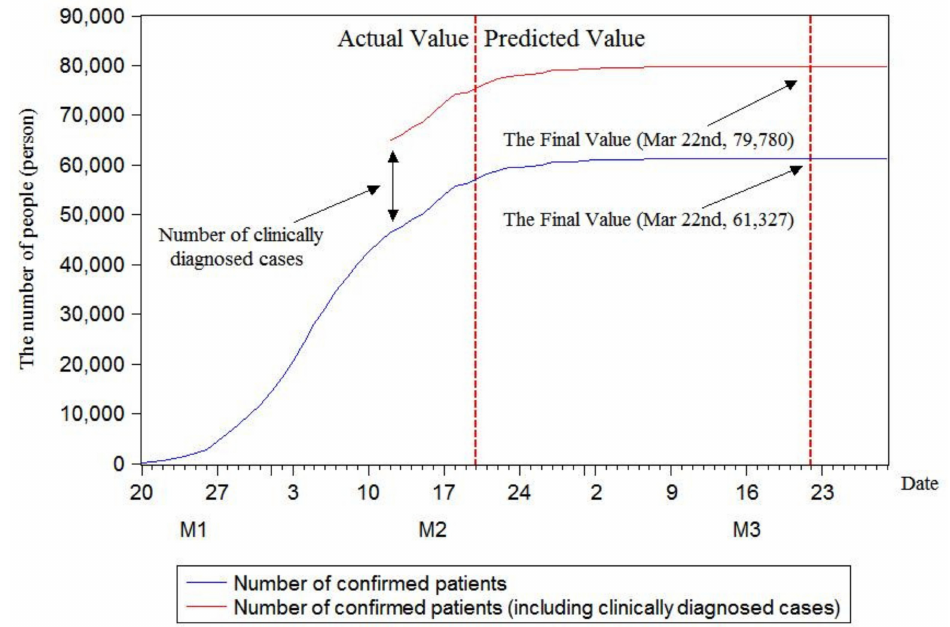
Figure 7. Model prediction with rolling sequence length of